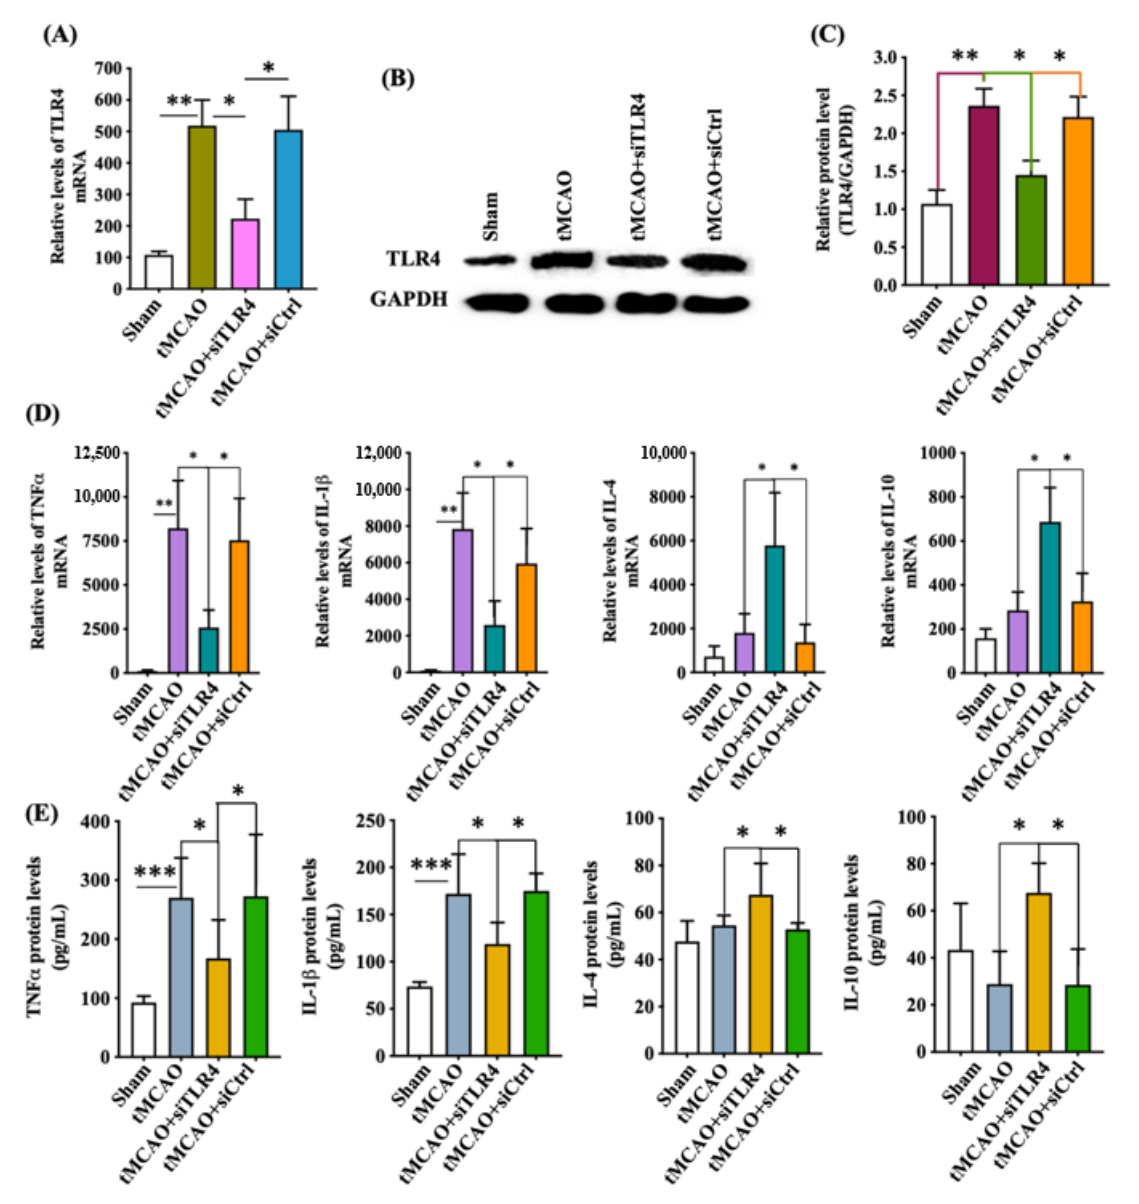
Figure 7. Target gene knockdown efficiency and differentiated expression of cytokines induced by DoGo310 LNP-mediated siRNA delivery in tMCAO mouse. ( A – C ) Analysis of target gene expression by RT-qPCR and Western blot after transfection siTLR4/DoGo310 complex; ( D , E ) silencing of TLR4 in OGD-treated microglia results in decrease in key proinflammatory cytokines, while resulting increase in anti-inflammatory cytokines, as analyzed by RT-qPCR and ELISA. * p < 0.05, ** p < 0.001, *** p < 0.0005 compared to untreated cells.